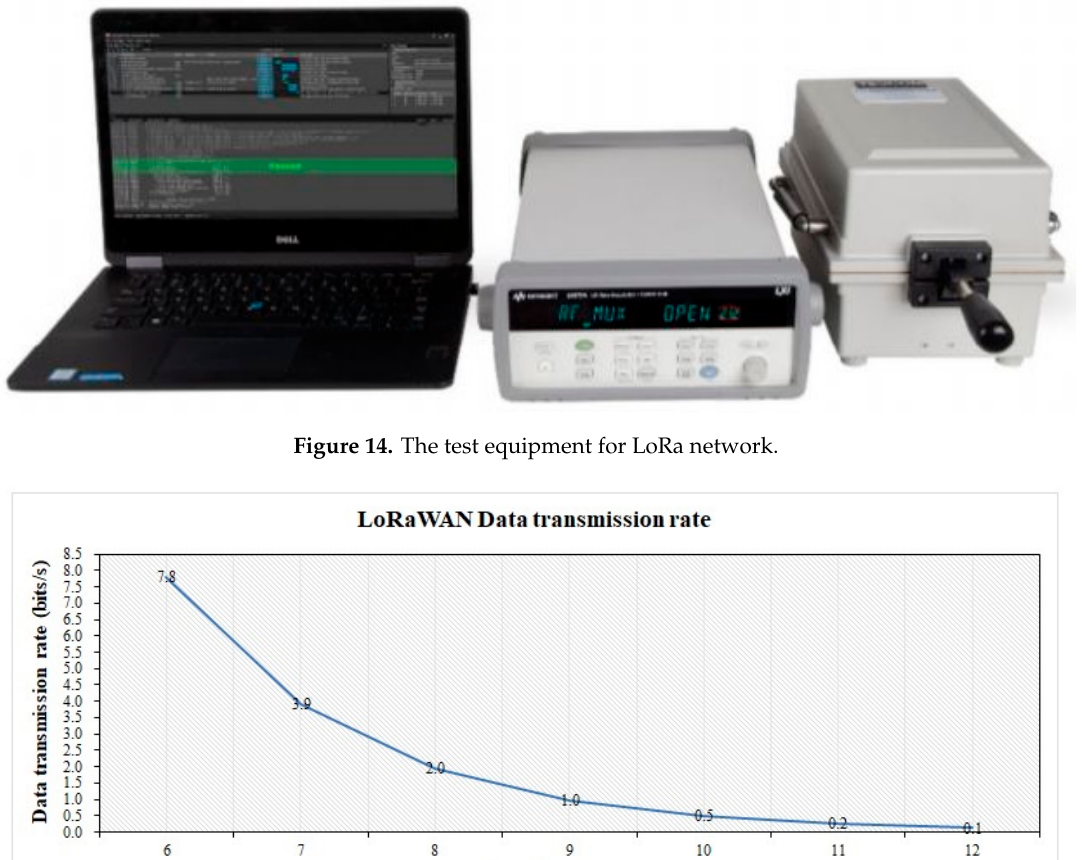
Figure 13. The prototype of the LoRa gateway module